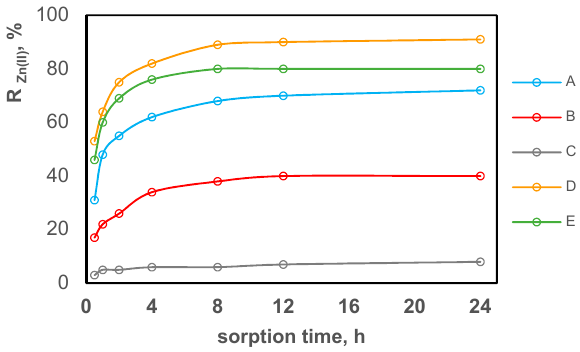
Figure 7. The reduction in zinc ion concentration expressed as a percentage of sorption on PVC-based composites promoted with acac depending on the contact duration.